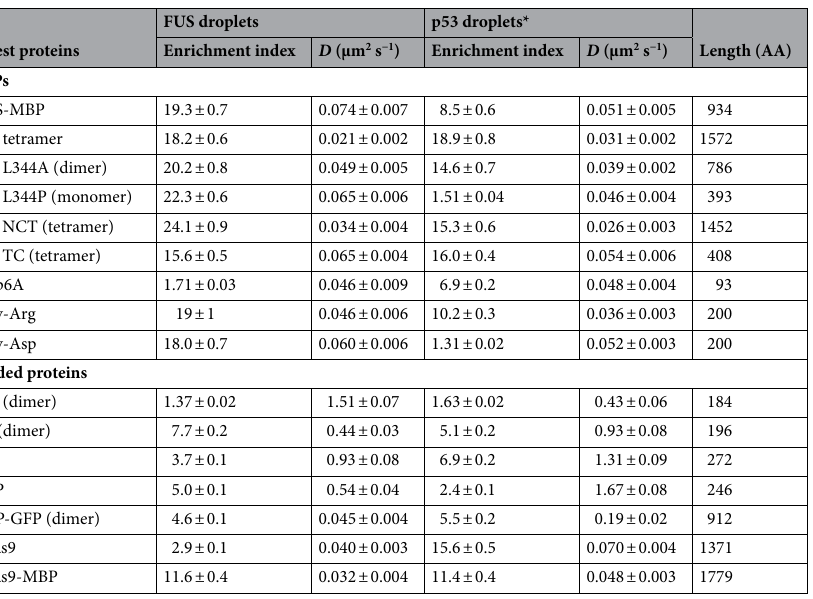
Table 1. Enrichment indices, physical parameters, and diffusion coefficients of guest proteins in FUS and p53 droplets. *Data in the p53 droplets were obtained from Kamagata et al. 13